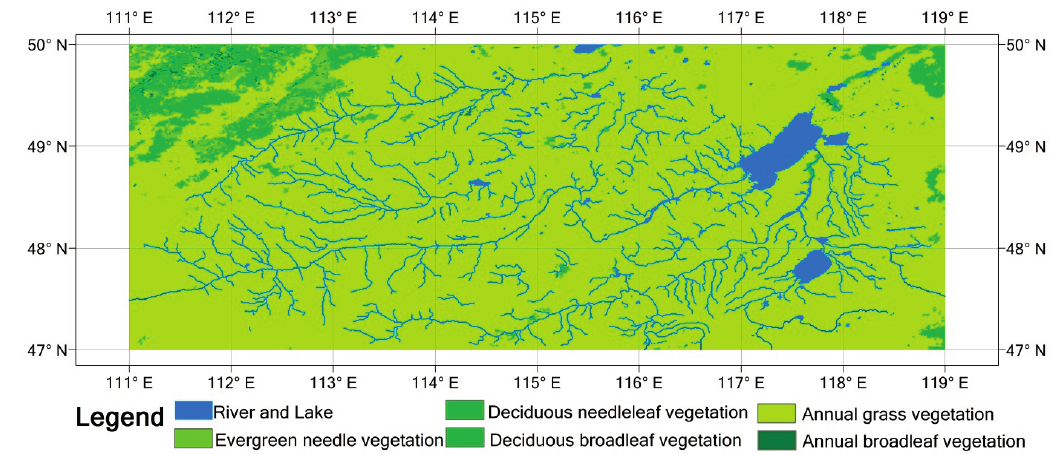
Figure 2. Vegetation map of study